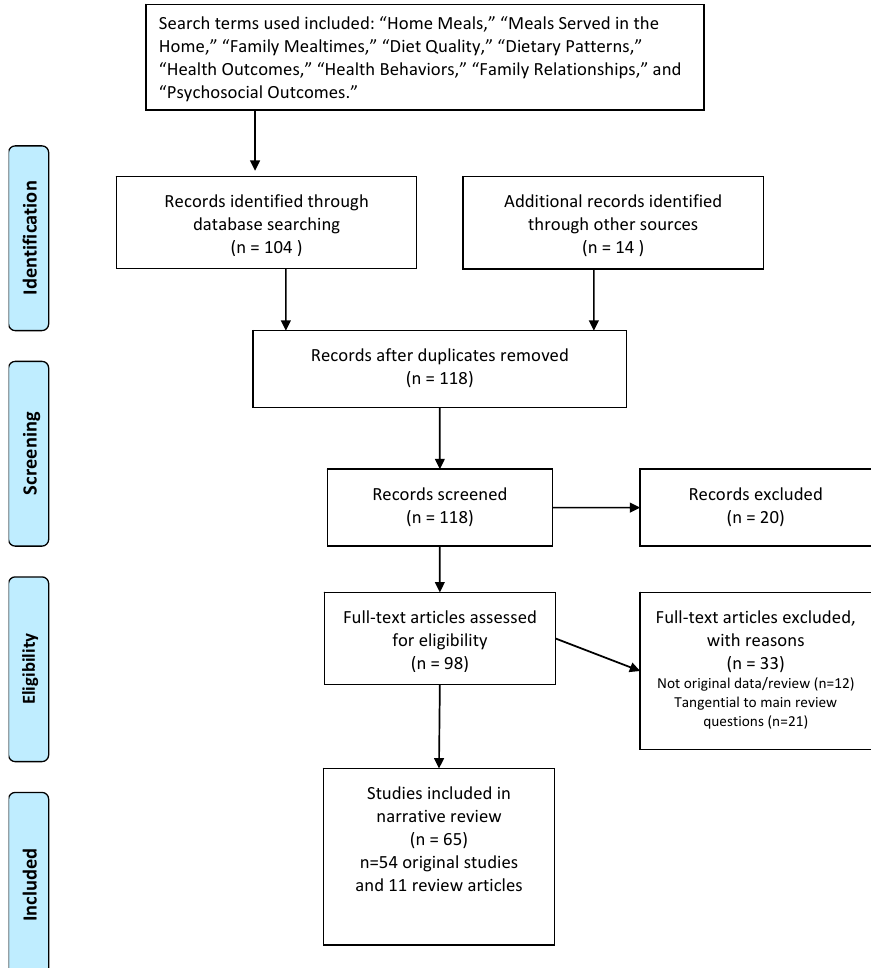
Figure 1. Flow Diagram.